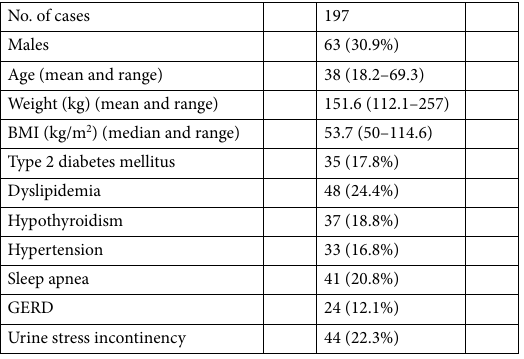
Table 1. Basic demographics of patients undergoing one anastomosis gastric bypass.